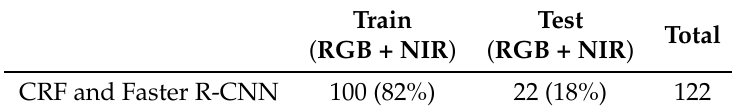
Table 1. Number of images used for training and testing for CRF and Faster